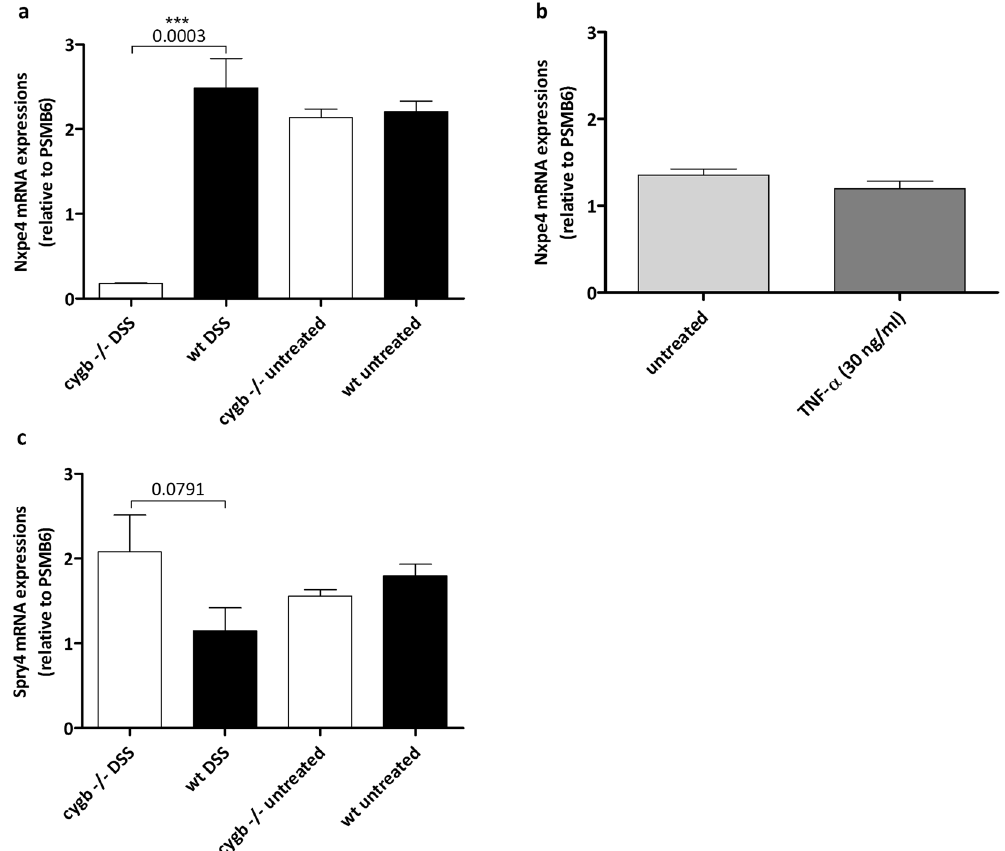
Figure 6. Nxpe4 and Spry4 mRNA expression levels. ( a ) Nxpe4 mRNA expression in colon tissue from week 7 AOM/DSS-treated C57BL/6 mice, WT (n = 8), Cygb − / − (n = 5), untreated control WT (n = 8) and Cygb − / − mice (n = 8). ( b ) Nxpe4 mRNA expression in cultured organoids from isolated WT colonic epithelial crypts, untreated colonic epithelial crypts (n = 6) and colonic epithelial crypts treated with 30 ng/ml TNF- α (24 h) (n = 6). ( c ) Spry4 mRNA expression in colon tissue from week 7 AOM/DSS-treated C57BL/6 mice, WT (n = 8), Cygb − / − (n = 5), untreated control WT (n = 8) and Cygb − / − mice (n = 8). Data are shown as the mean ± SEM. Statistical analysis was performed using Student’s t-test, and P values are shown. P values < 0.05 were considered statistically significant.